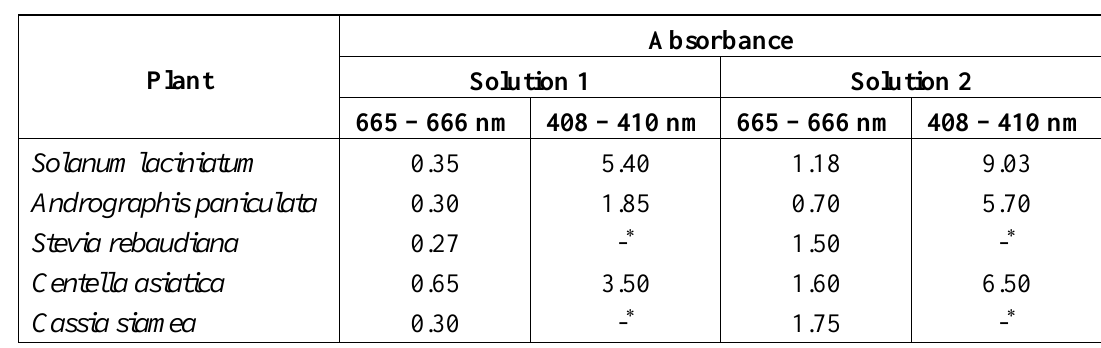
Table 1. Absorbances of plant extracts obtained after dechlorophyllation by EC (Solution 1) and by solvent extraction (Solution